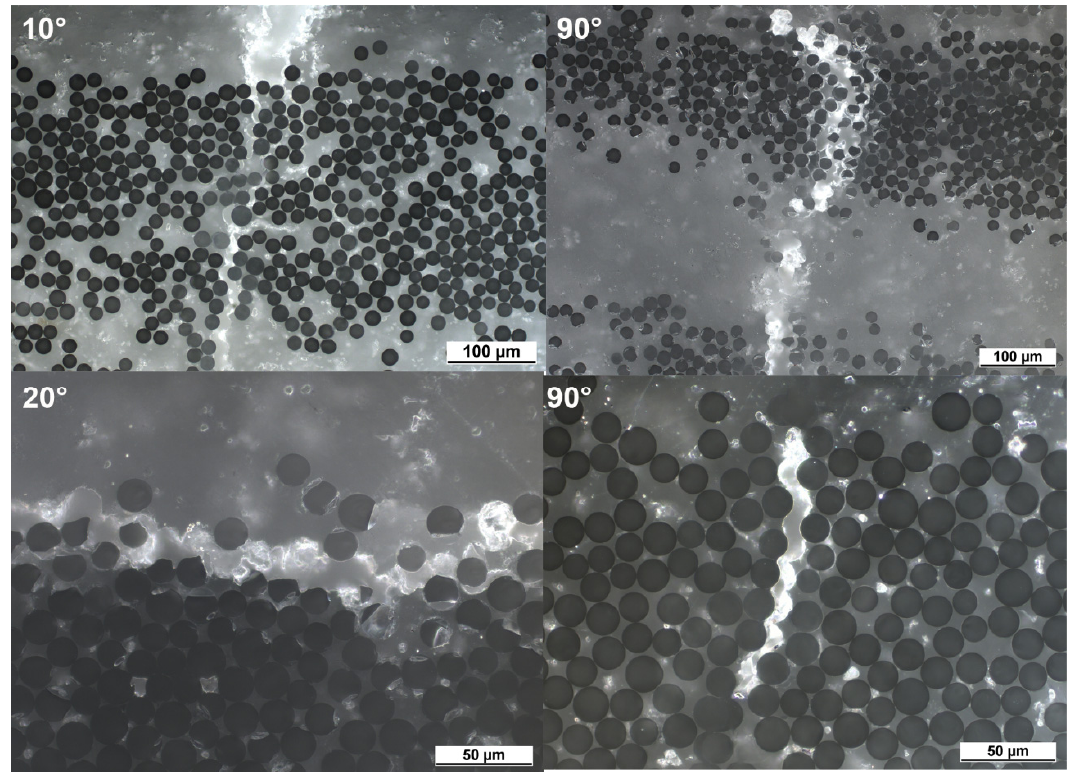
Figure 8. Damage events in off ‐ axis samples after tensile creep loading.